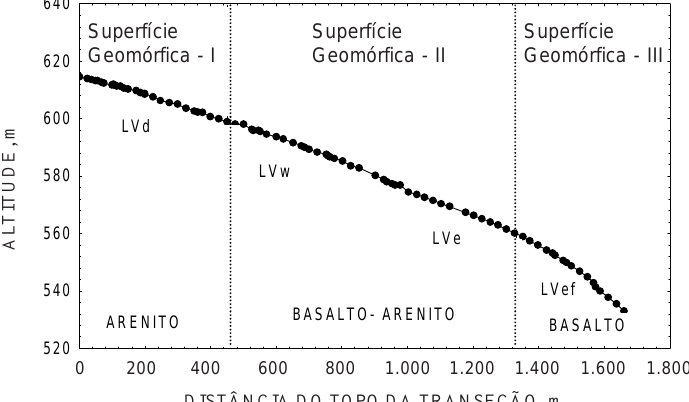
Figura 4. Perfil topográfico do segmento de vertente estudado, mostrando limites das três superfícies geomórficas, as respectivas unidades de mapeamento de solos e o substrato rochoso. (LVd = Latossolo Vermelho distrófico textura média; LVw = Latossolo Vermelho ácrico argiloso; LVe = Latossolo Vermelho eutrófico muito argiloso; LVef = Latossolo Vermelho eutroférrico muito